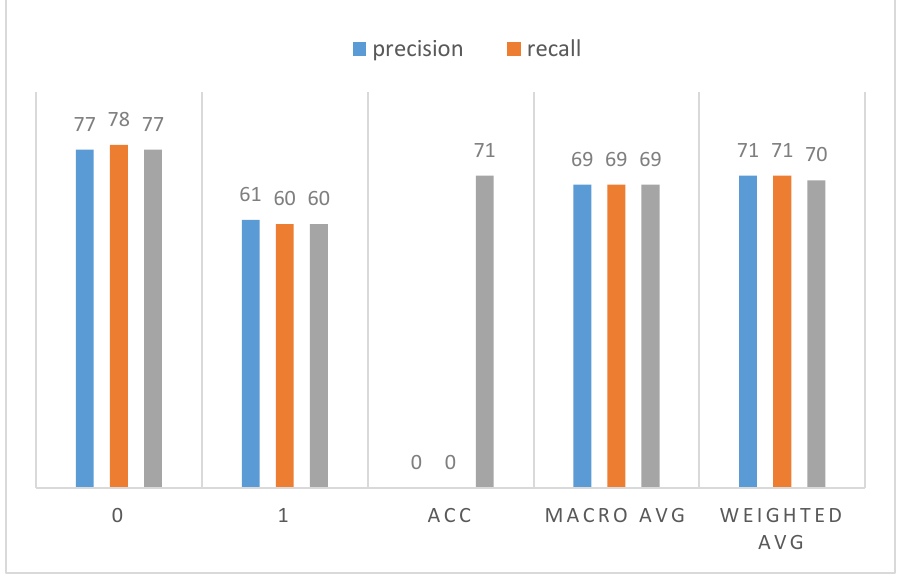
Figure 13. Summary of results for a testing dataset equal to 40% and training dataset of 60%. A greater difference between the specified parameters can be seen for the values of the test dataset equal to 40% and training dataset size 60% (Figure 13). As the percentage of testing data increased and the percentage of training data decreased, it was noted that the values for all parameters were at a consistently high level.